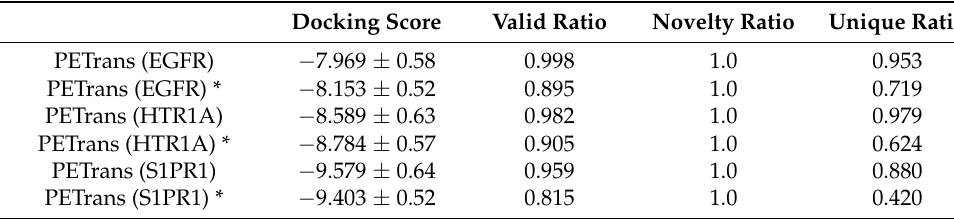
Table 3. Experimental results with and without control of the docking